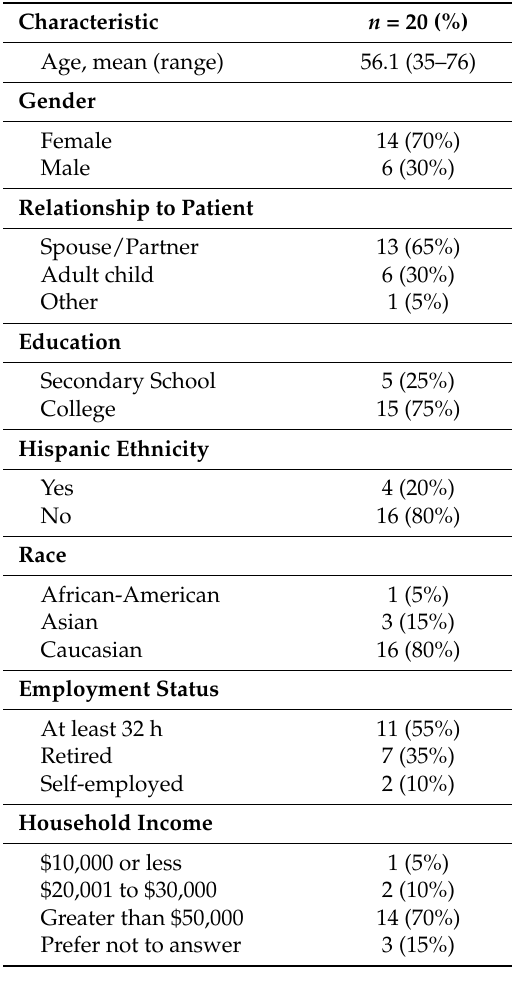
Table 1. Caregiver